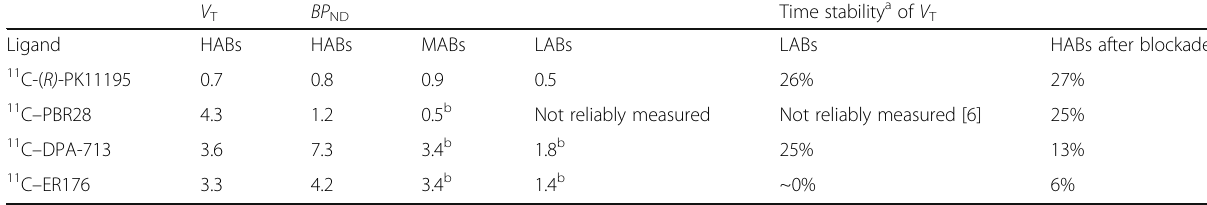
Table 1 Distribution volume and the time stability of four 11 C – radioligands to image translocator protein (TSPO) V BP T ND